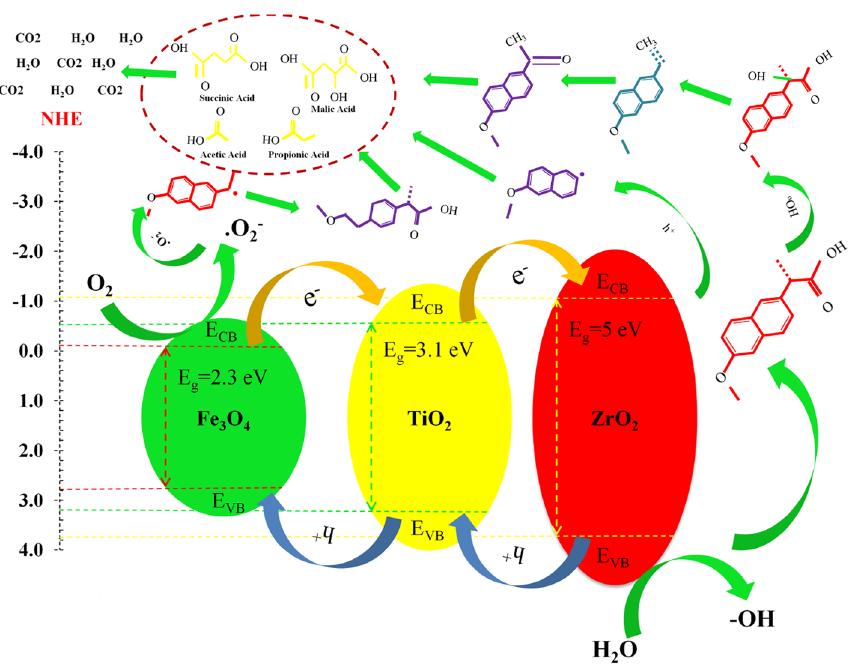
Figure 15. Photo degradation reaction mechanism of NPX by ZrO 2 /TiO 2 /Fe 3 O 4